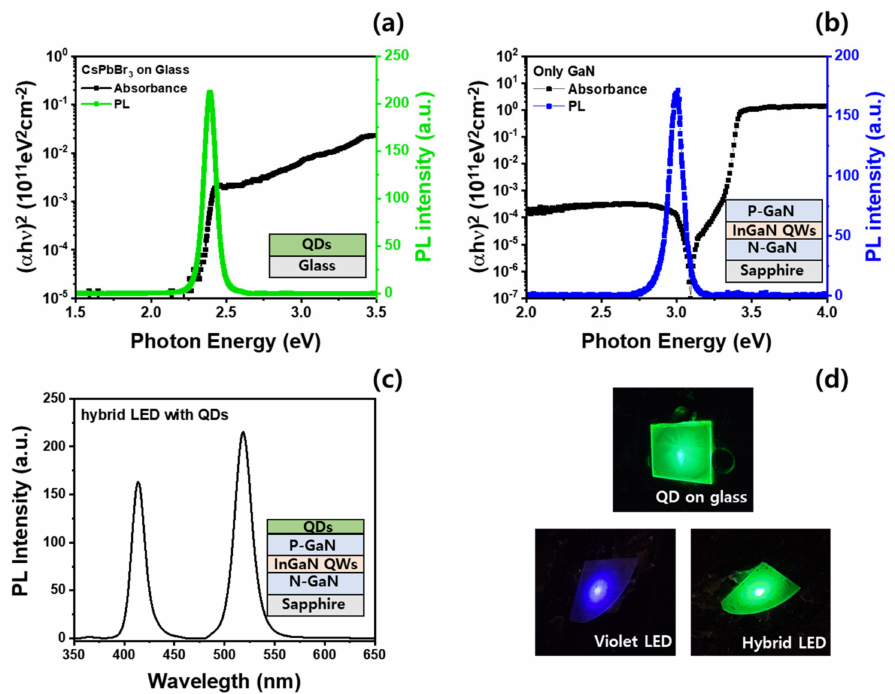
Figure 2. Room-temperature PL and absorption spectra of ( a ) spin-coated CsPbBr 3 QDs on glass, ( b ) conventional InGaN-based LED, and ( c ) hybrid InGaN-based LED using CsPbBr 3 QD; ( d ) images of the PL emissions obtained from the spin-coated CsPbBr 3 QDs on glass, conventional InGaN-based LED, and hybrid InGaN-based LED using CsPbBr 3